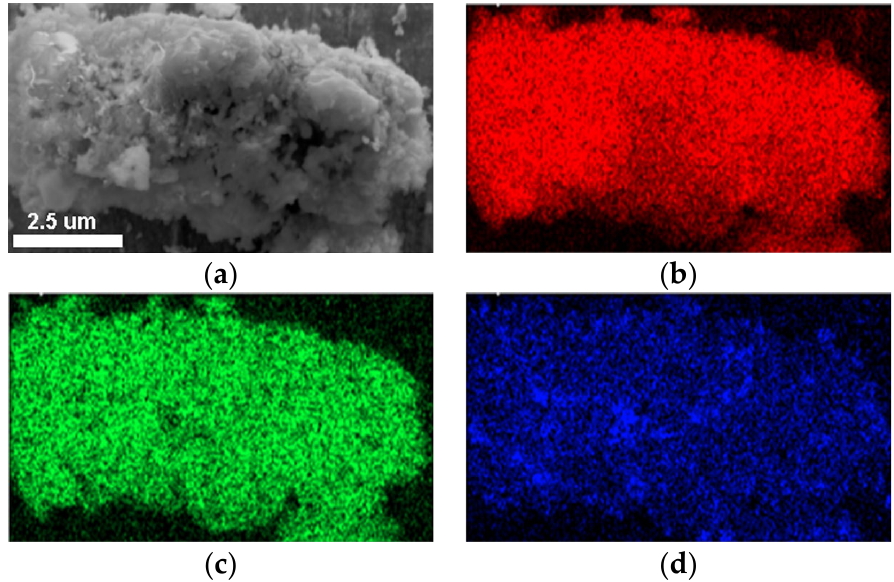
Figure 9. SEM image ( a ) and the elemental analysis mapping showing the distribution of O ( b ), Si ( c ), and Al ( d ) for the Sample SA - E . and Al ( d ) for the Sample